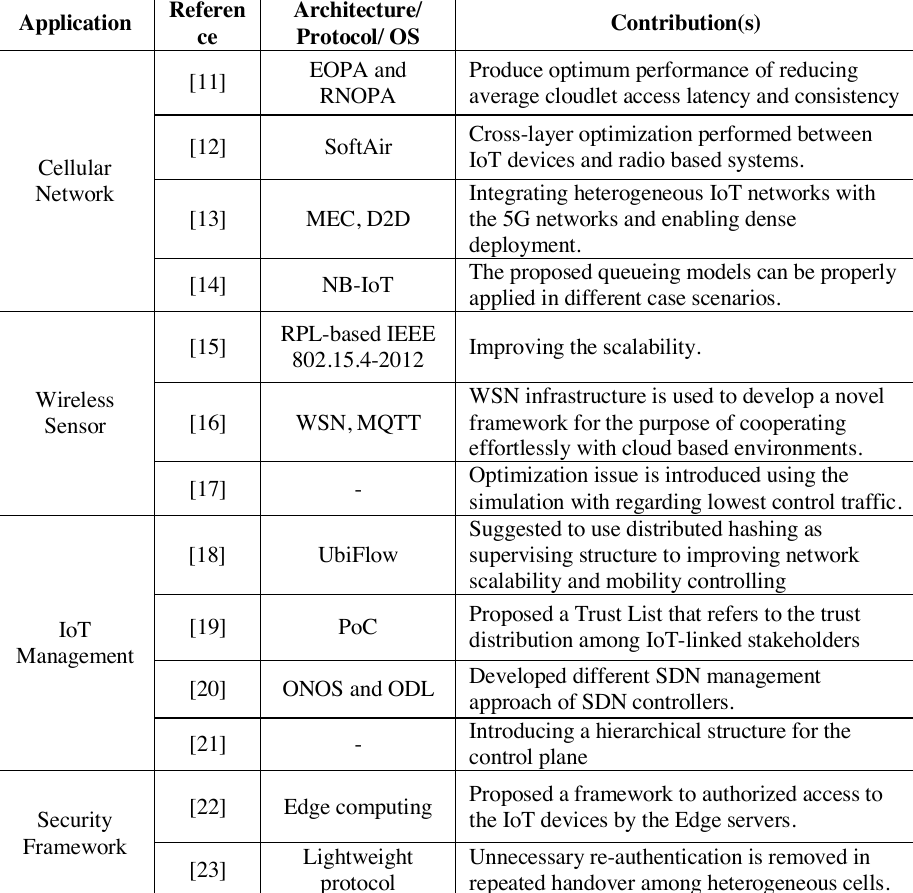
Table 1 . Summary of the SDN based proposed model for IoT